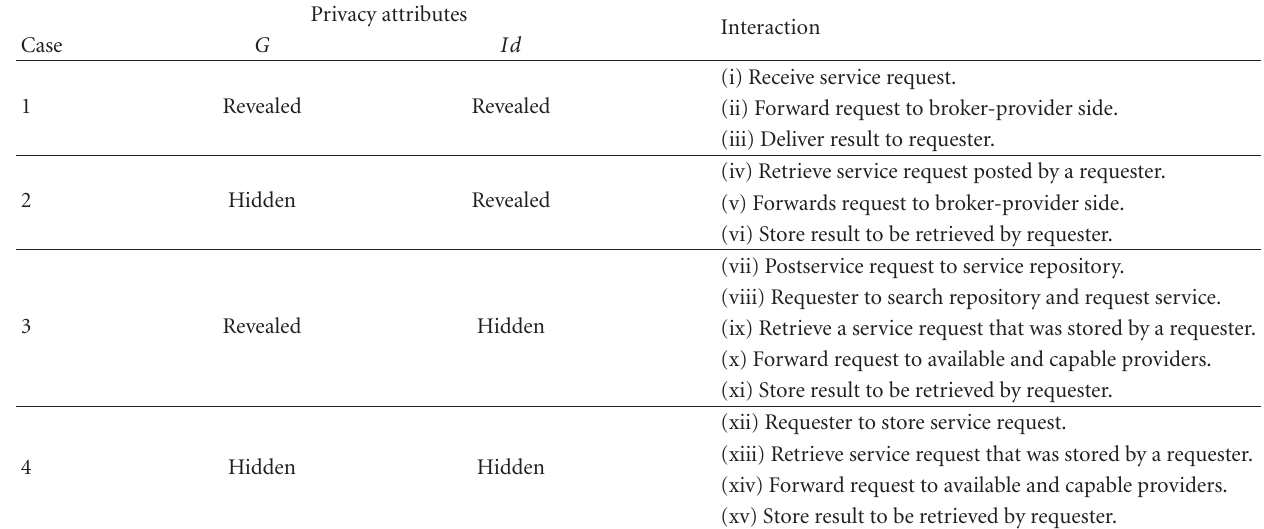
Table 1: The brokering layer interaction categorized by the privacy concern of service